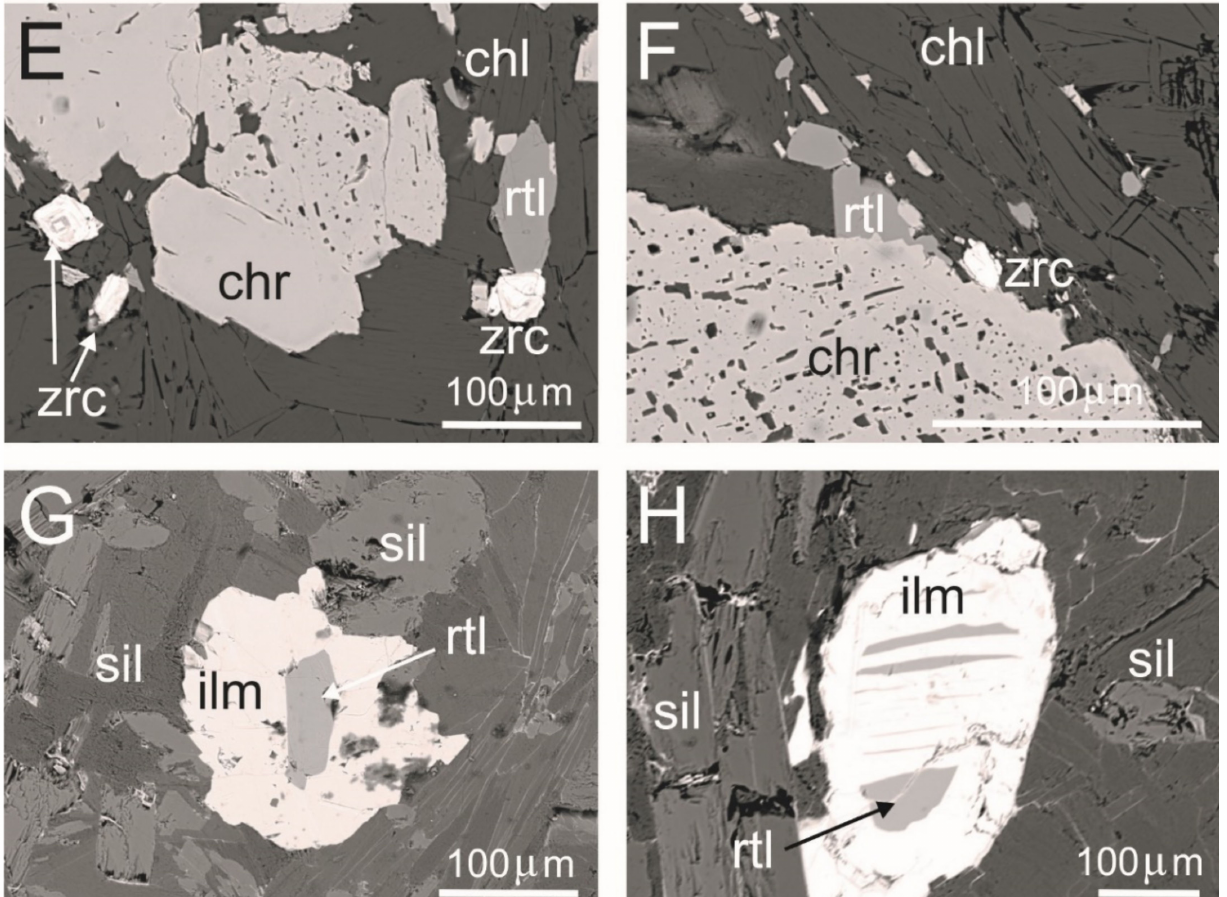
Figure 6. Texture typology of rutile in the metamorphic chromitite of Cedrolina (BSE images). Large rutile grains interstitial between chromite and chlorite (sample CD100) ( A , B ). Rutile grains attached to the boundary of altered chromite (samples CD105B and CD106D) ( C , D ). Notably, rutile in Figure 6B,D contains chromite inclusions. Rutile-zircon association in chlorite and attached to altered chromite (sample CD105C) ( E , F ). Rutile replaced by ilmenite in the altered matrix (sample CD169) ( G , H ). Abbreviations: zrc, zircon; others as in Figures 1 and 5.